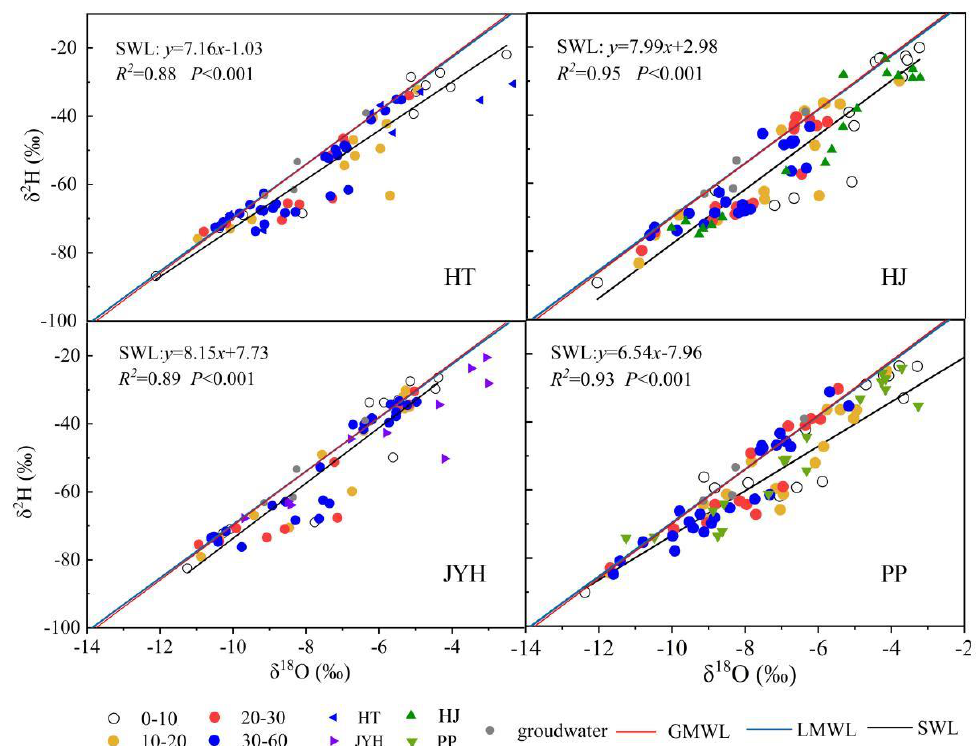
Figure 3. Seasonal variation of δ 2 H and δ 18 O values in xylem water of different water bodies and four plant species. The error bar represents the standard deviation. The δ 2 H and δ 18 O in rainwater represent the values of weighted averages per month.